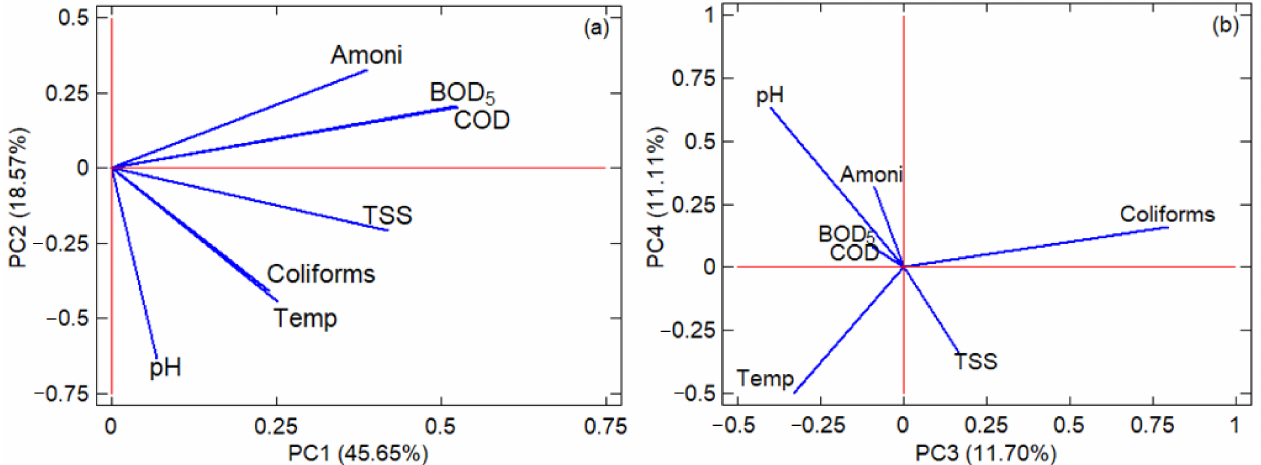
Figure 2. Key parameters influencing surface water quality ( a ) PC1 and PC2; ( b ) PC3 and